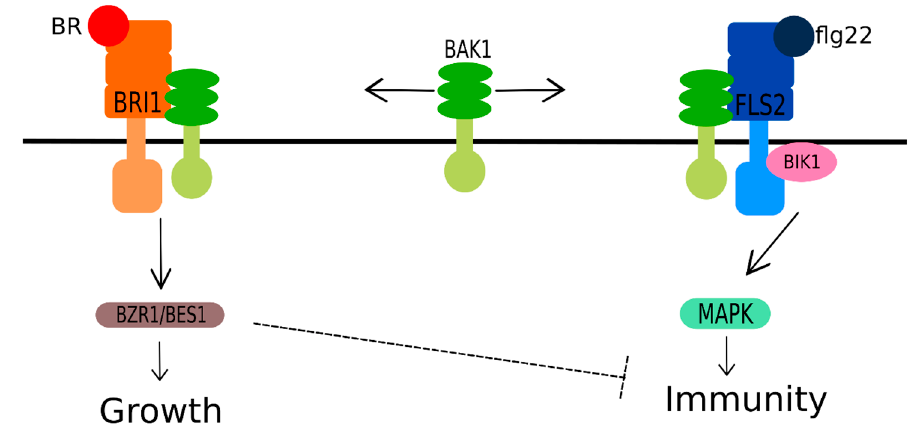
Figure 8. A suggested model of brassinosteroid (BR) regulation of immunity at multiple levels. BAK1 (BRI1-ASSOCIATED RECEPTOR KINASE 1) is considered to mediate the growth and immunity tradeoff because it serves as a coreceptor for both BR-mediated responses via BRI1 and innate immunity mediated responses via flg-sensing 2 (FLS2). The scheme suggests an inhibition of FLS2-mediated immune signaling by BR, independent of complex formation with coreceptor BAK1, when the inhibition occurs downstream of BAK1. BRI1 (BRASSINOSTEROID-INSENSITIVE 1) represents a BR receptor; flg22 (flagellin 22) is a type of pathogen- and microbe-associated molecule pattern (MAMP/PAMP); FLS2 (flg-sensing2) is a flg22 receptor; BIK1 (BOTRYTIS-INDUCED KINASE 1) is a coreceptor of FLS2; BZR1/BES1 (BRASSINAZOLE RESISTANT 1/BRI1-EMS SUPPRESSOR 1, respectively) are the major transcriptional factors of the BR signaling pathway; MAPKs (mitogen activated protein kinases) are a class of marker proteins which indicate various stress conditions.